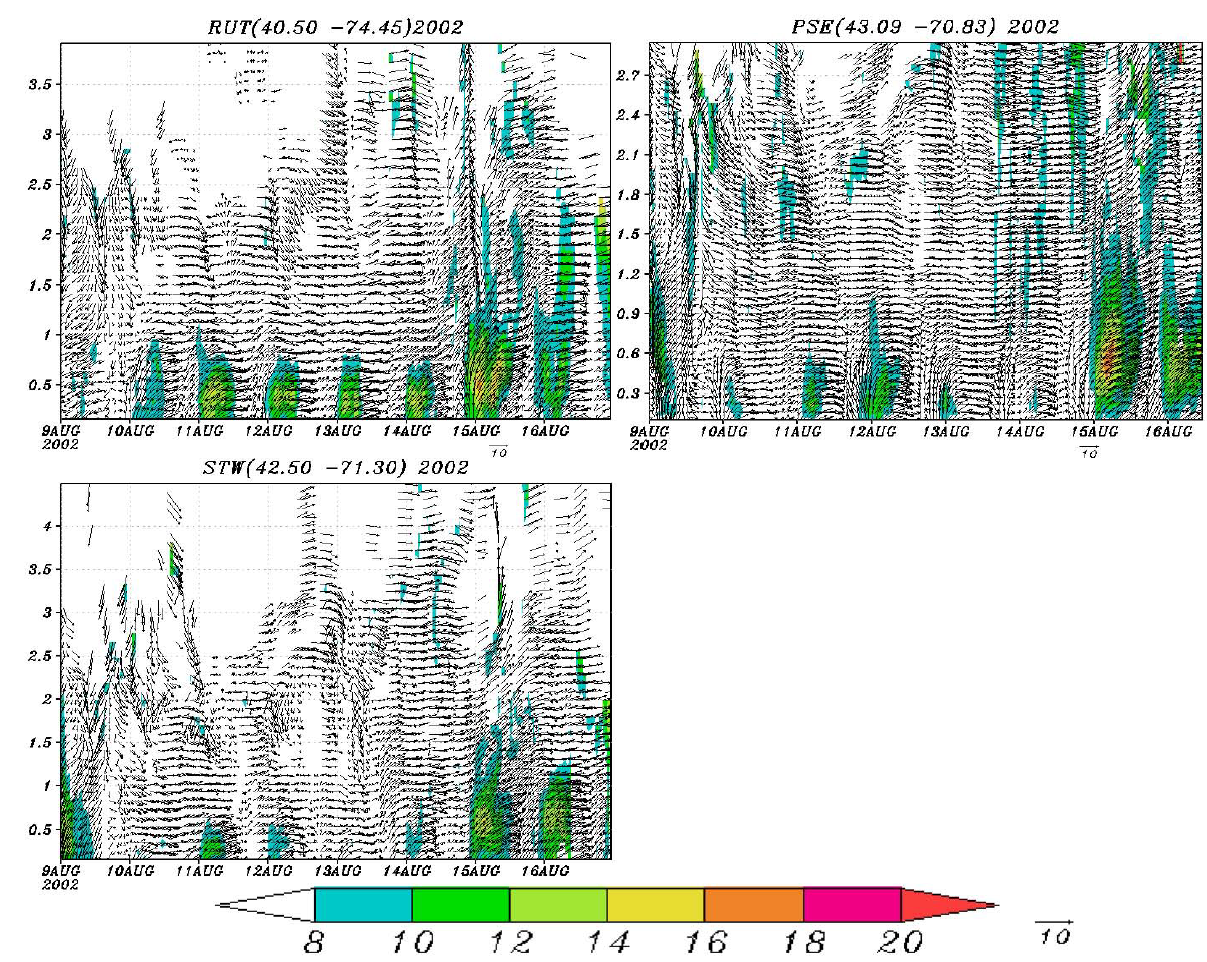
Figure 8. The radar wind observations at RUT, PSE, and STW. X-axis is observational date from 9–16 August. Y-axis is height in kilometers. Wind vector was drawn when data was available. Shaded areas are wind speeds higher than 8 m/s in 2 m/s interval